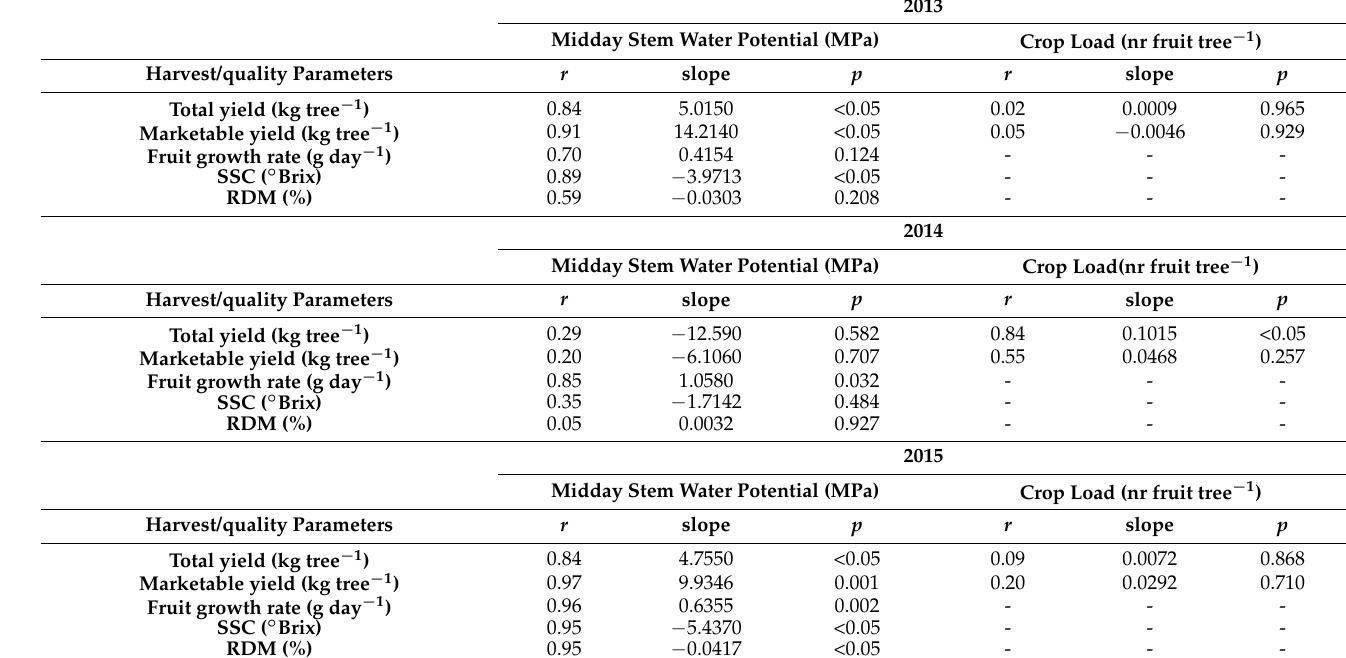
Table 7. Correlation coefficient ( r ), slope, and significance ( p -value) of the linear relationships between the calculated harvest and quality parameters (vertically listed) and midday stem water potential and crop load (horizontally listed) for the 2013, 2014, and 2015